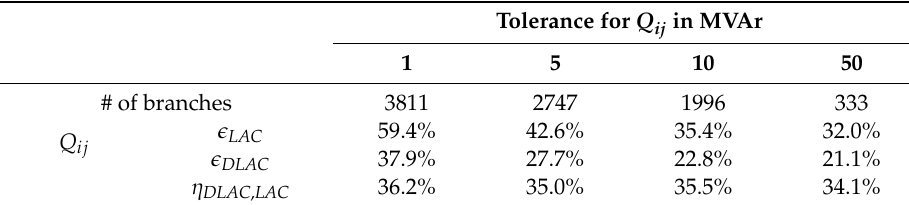
Table 11. Results of Reactive Power with DLAC and LAC for Hour 2 Case.